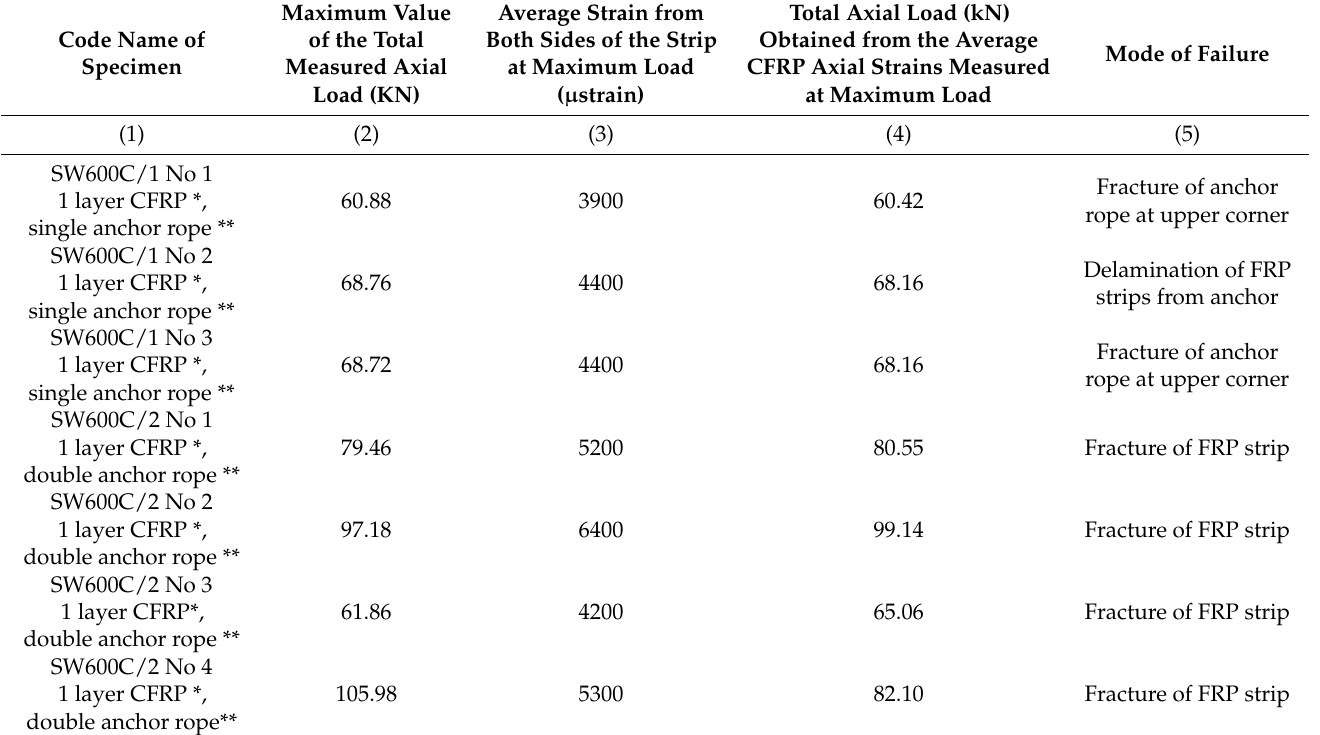
Table 3. Measured tensile capacity of open hoop CFRP strips anchored with CFRP